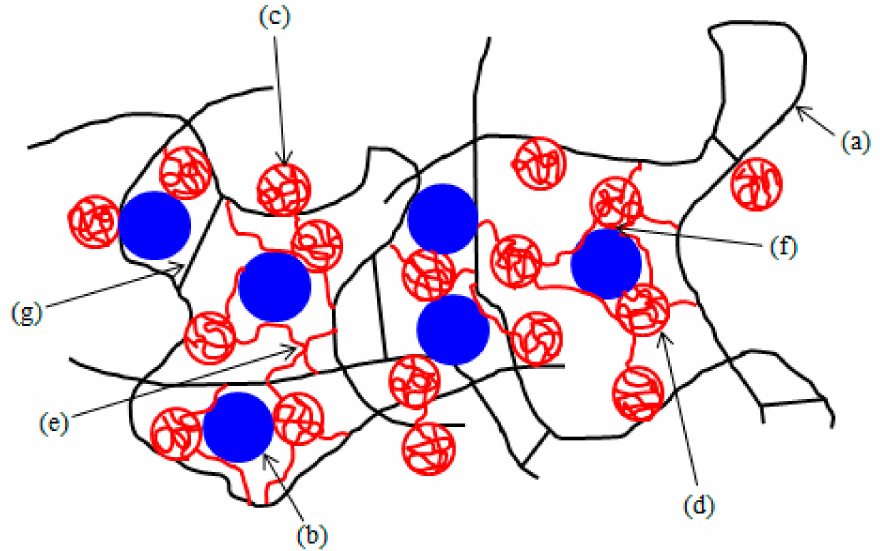
Figure 7. Schematic representation of the micro-structure model of rubber magnetic composites cured in the presence of peroxide and zinc acrylate or zinc methacrylate: ( a ) rubber chains; ( b ) particles of ferrite; ( c ) polymerized molecules of co-agents physically adsorbed onto rubber chains; ( d ) polymerized molecules of co-agents chemically grafted onto rubber chains; ( e ) ionic physical cross-links formed from co-agents; ( f ) physical interactions between particles of ferrite and polymerized molecules of co-agents; and, ( g ) covalent carbon-carbon